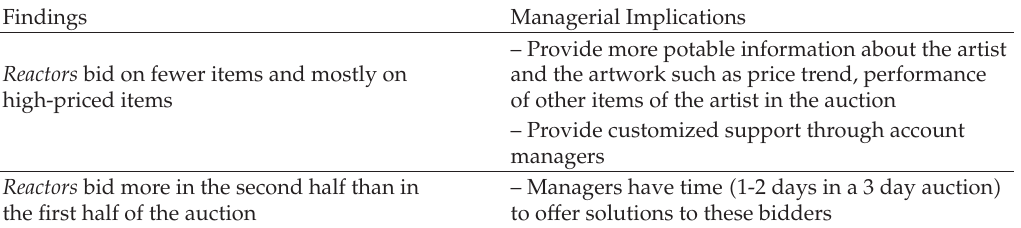
Table 6: Managerial